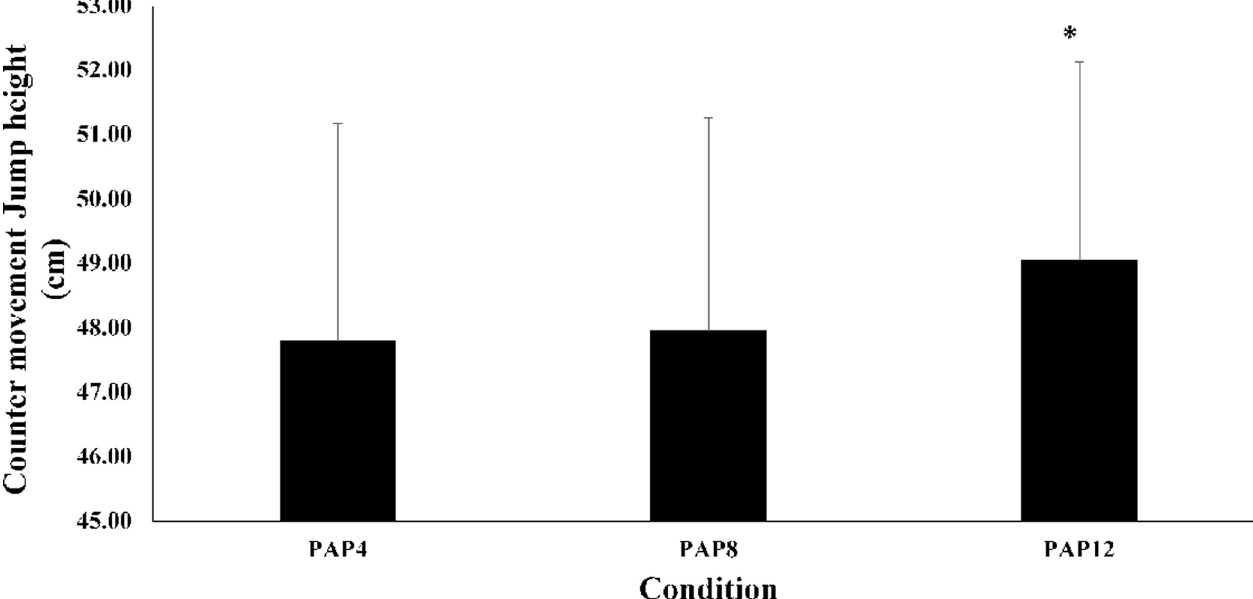
Fig 2. Mean ± SD for countermovement jump height (cm) for the PAP4, PAP8 and PAP12 conditions. � Denotes a statistical significance compared to other conditions (P < 0.0005).